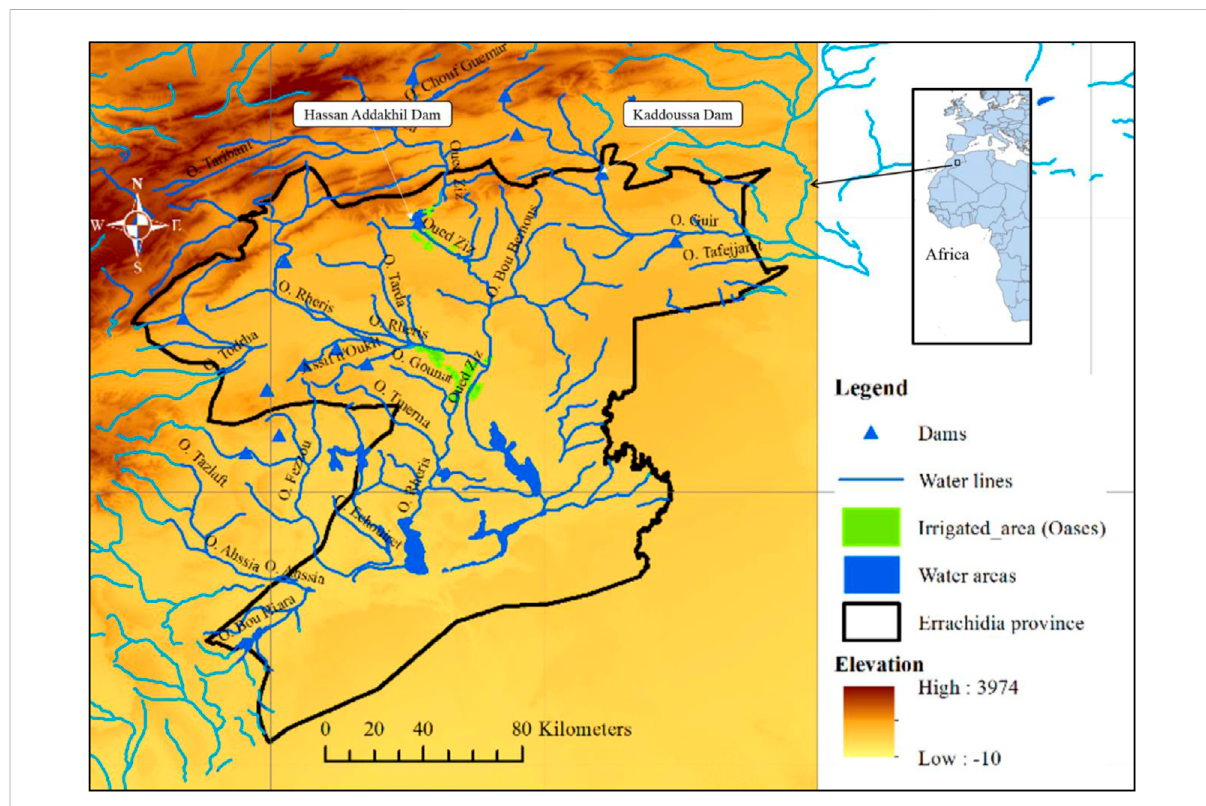
FIGURE 1 Localization of the study area, the Errachidia Province, Southeastern Morocco. SRTM elevation data offers Digital Elevation Model (DEM) at global scope with a resolution of 30 m. It was downloaded from NASA Earth Data Server (https://urs.earthdata.nasa.gov) using the QGIS